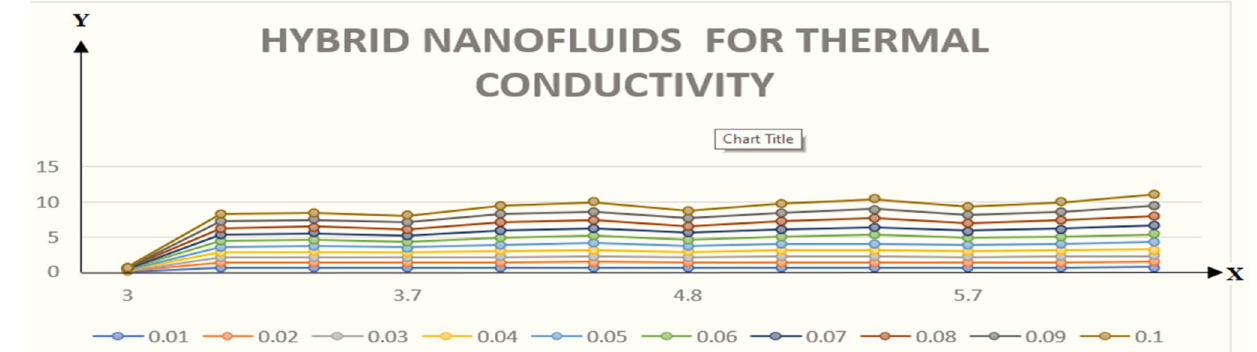
Figure 2. Suggested thermal conductivity behavior for HN fd .